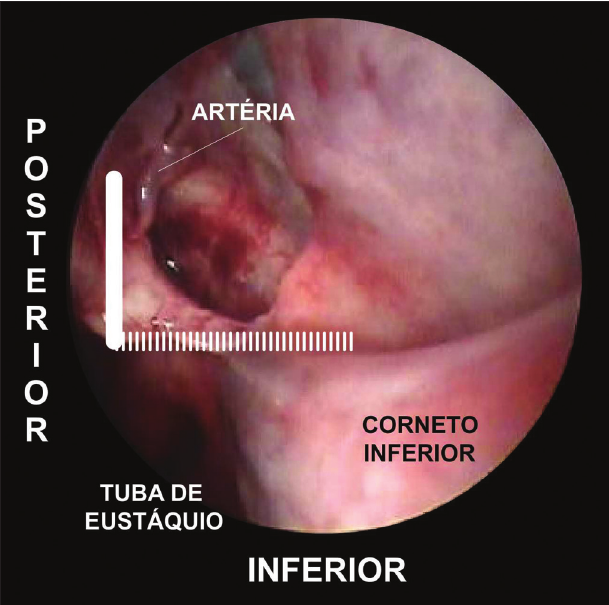
Figura 5. Fotografia da fossa nasal esquerda. O limite inferior do “quadirilátero esfenopalatino” é a porção superior do corneto inferior. Já a tuba de Eustáquio é o limite posterior do retalho